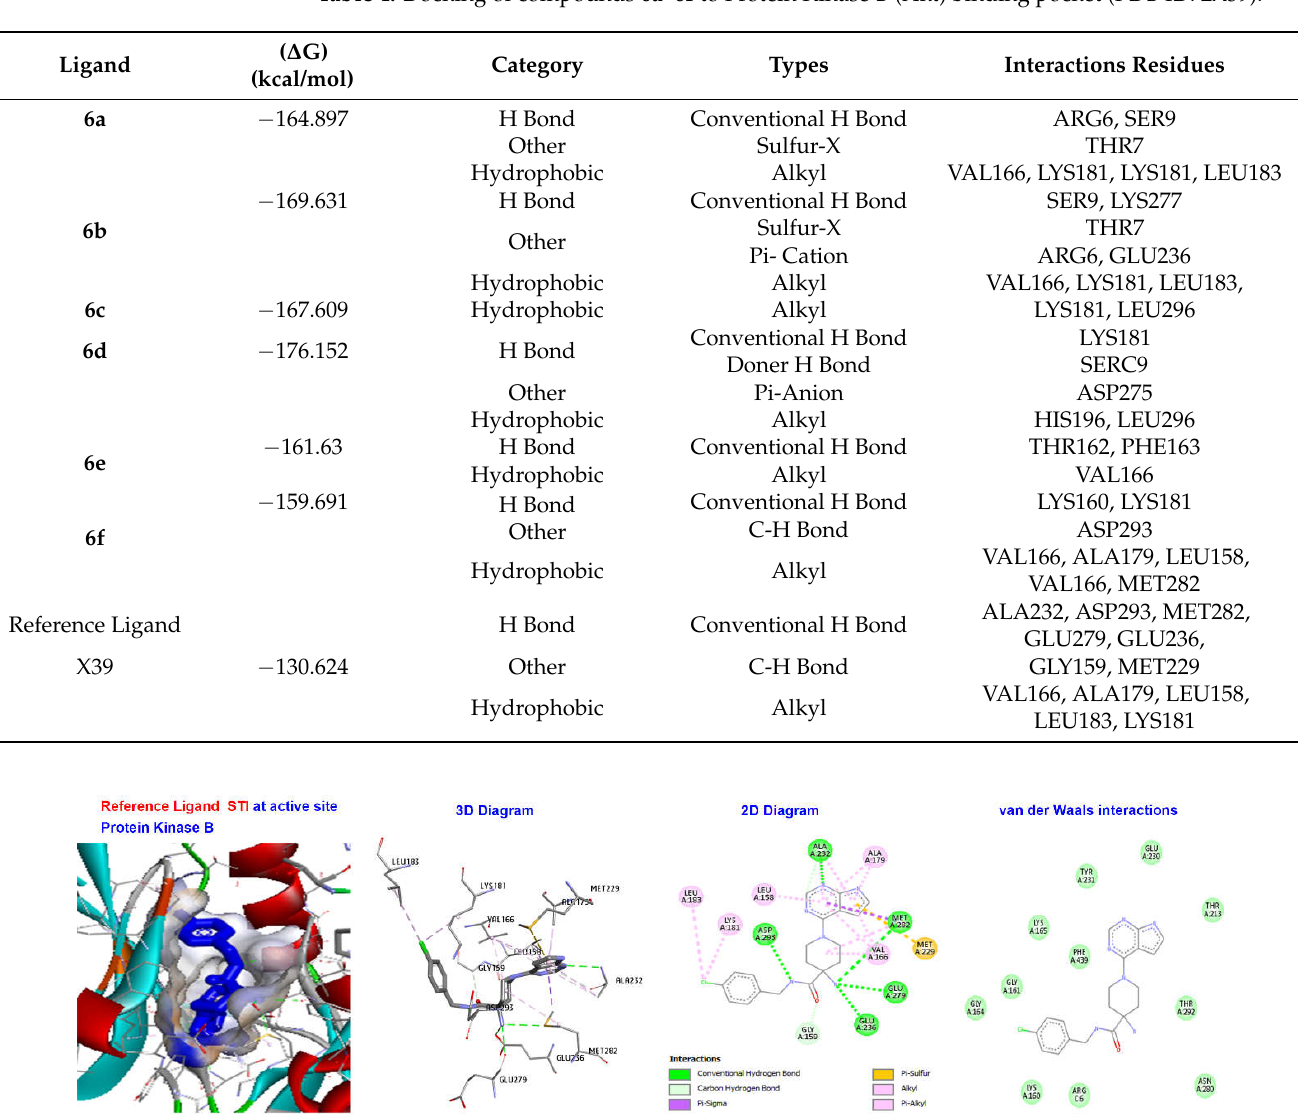
Figure 3. Binding interactions of reference ligand (X39) with Protein Kinase binding pocket. Table 4. Docking of compounds 6a–6f to Protein Kinase B (Akt) binding pocket (PDB ID: 2X39).